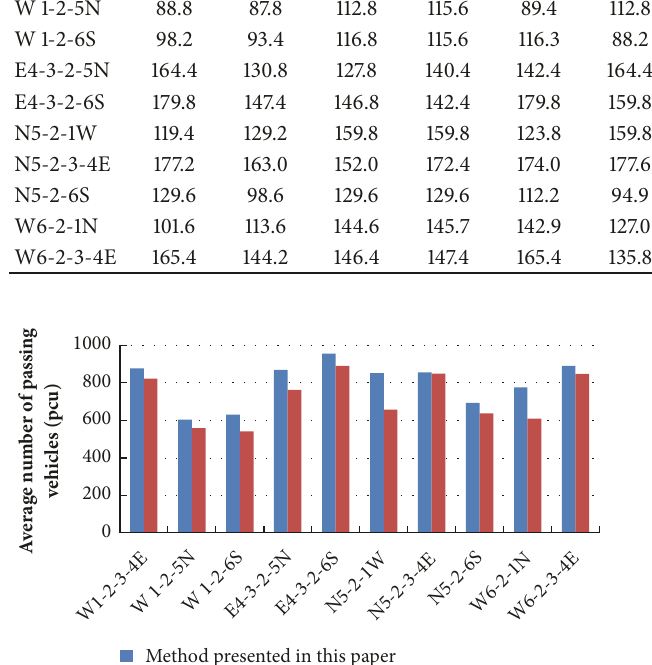
Figure 7: The average number of social vehicles passed through at all